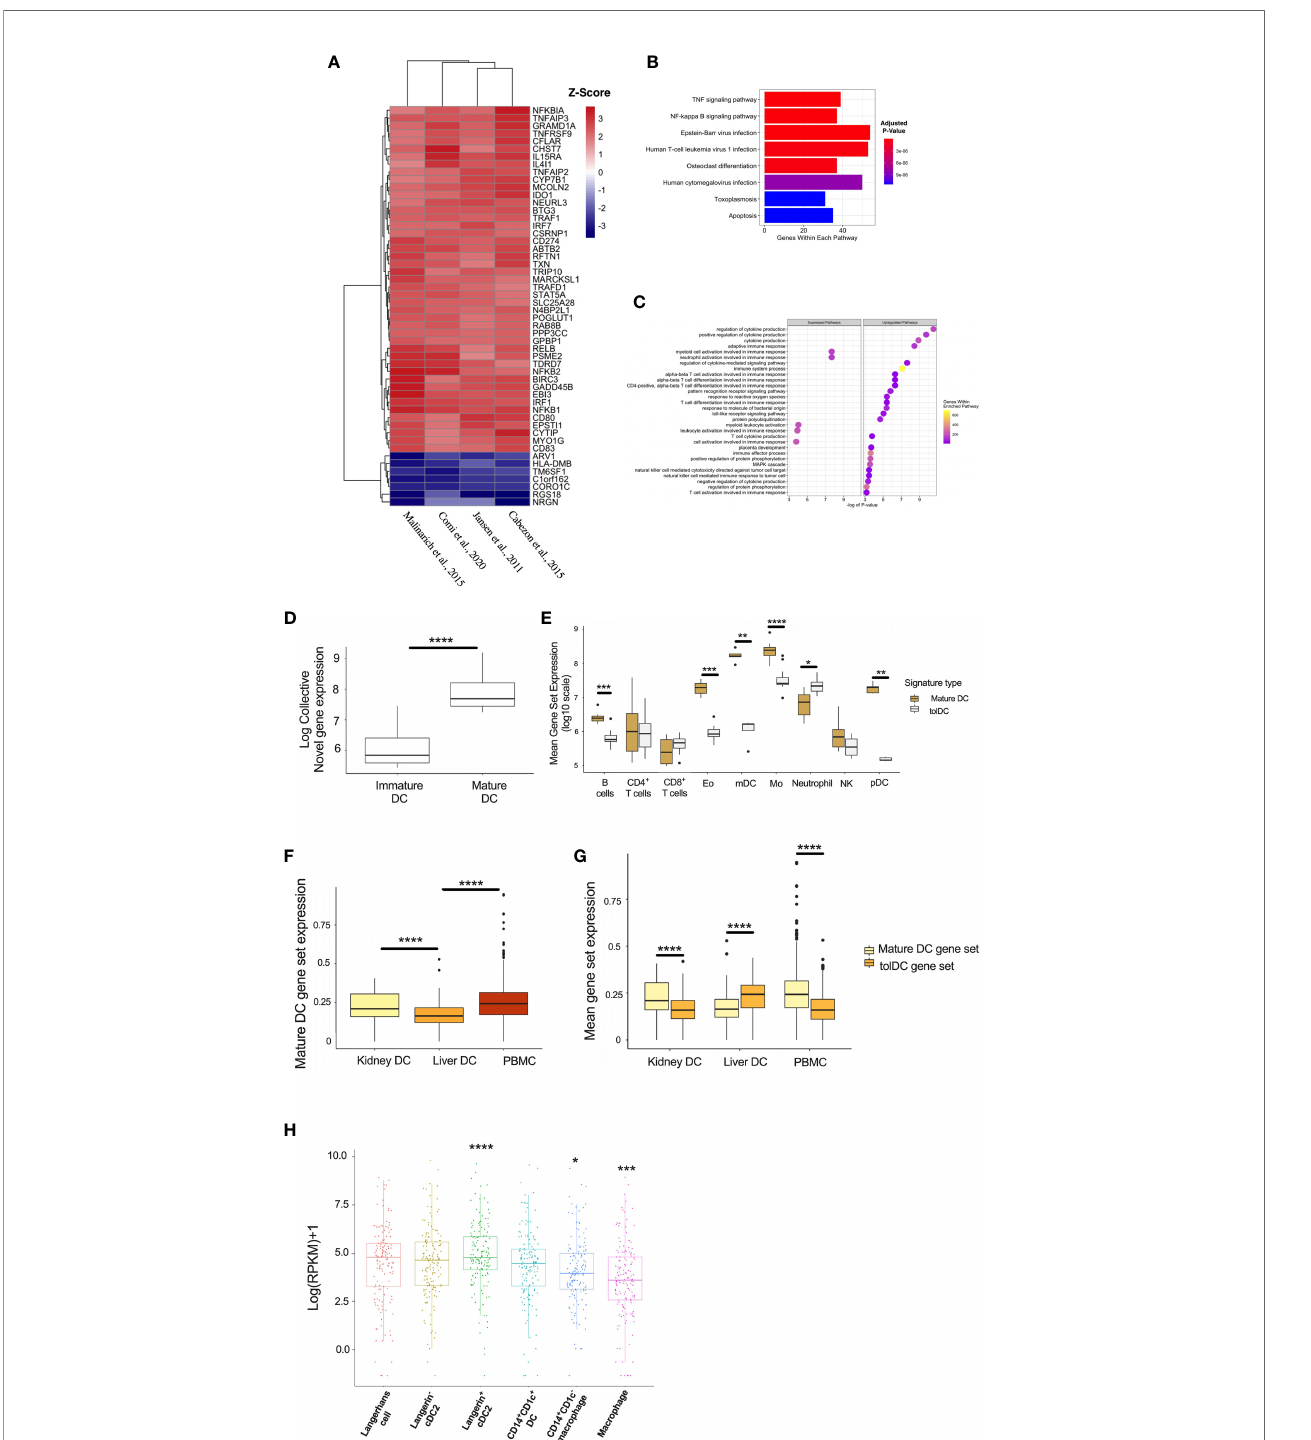
FIGURE 6 | Generating a mature DC transcriptome. (A) Heatmap representation of the top 52 DEG within the mature DC phenotype. (B) KEGG and (C) Gene Set Enrichment Analyses. (D) Mature DC gene-set expression in myeloid cell subsets isolated from epithelial tissues. (E) Comparison of tolDC and mature DC gene signatures in peripheral blood immune cell subsets. (F) Boxplot displaying the expression of genes critical to mature DC across DC in liver, kidney and PBMC. (G) Comparison of tolDC and mature DC gene set expression in liver, kidney and PBMC. (H) Mononuclear phagocytes from epithelial and subepithelial tissues were isolated and classi fi ed as DC or macrophage. The average expression of the mature DC gene signature was plotted between cells. A two-sample t-test was performed to determine statistically signi fi cant differences in base mean expression of the mature DC gene set across MNP. *p < 0.05, **p < 0.01, ***p < 0.001, ****p <